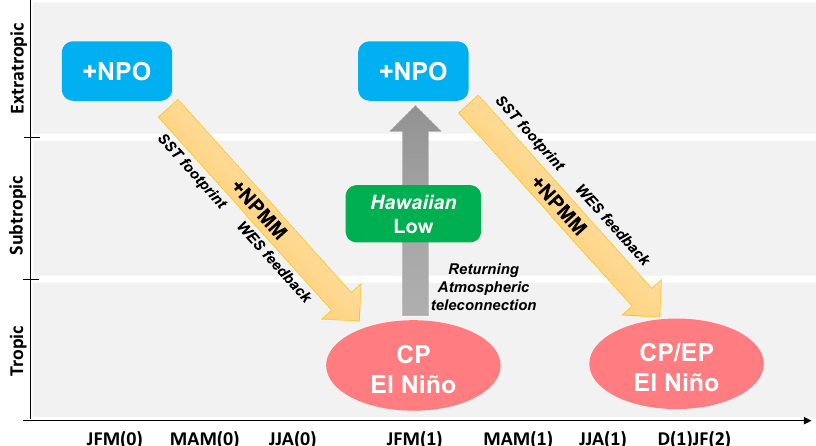
Fig. 4 Schematic diagram illustrating the two-way feedback mechanism between the tropics and extratropics. The positive NPO forcing during JFM(0) can induce an SST footprint in the subtropical northeastern Paci fi c during MAM(0) by changing the northeasterly trade winds, which resembles a positive phase of the NPMM. The NPMM interacts with the trade winds and extends positive SST anomalies equatorward into the central equatorial Paci fi c through the WES feedback, leading to a CP-type El Niño event over the equatorial Paci fi c during the subsequent JFM(1). This CP-type El Niño in turn feeds back into the North Paci fi c to force changes in the atmospheric circulation over the Hawaiian region that project onto the NPO variability, which re-activates the NPMM to favor the development of another CP-type or EP-type El Niño event. Through this two-way feedback process between the tropics and extratropics, the NPO contributes to multi-year persistence of El Niño events in the tropical Paci fi event during JFM(0) (Supplementary Fig. 10d), are character- result, the NPMM is very weak ( NPMM index j j < 0.5 SD) ized by a typical EP El Niño pattern during JFM(1) during MAM(1) (Supplementary Fig. 10i), and the warming in (Supplementary Fig. 10b). Consistent with the location of the equatorial central − eastern Paci fi c evolves rapidly to a La maximum warming, there is only a weak positive SLP response Niña-like condition by JFM(2) (Supplementary Fig. 10c), over the Hawaiian region (Supplementary Fig. 10e, h). As a thereby leading to a single-year El Niño event.